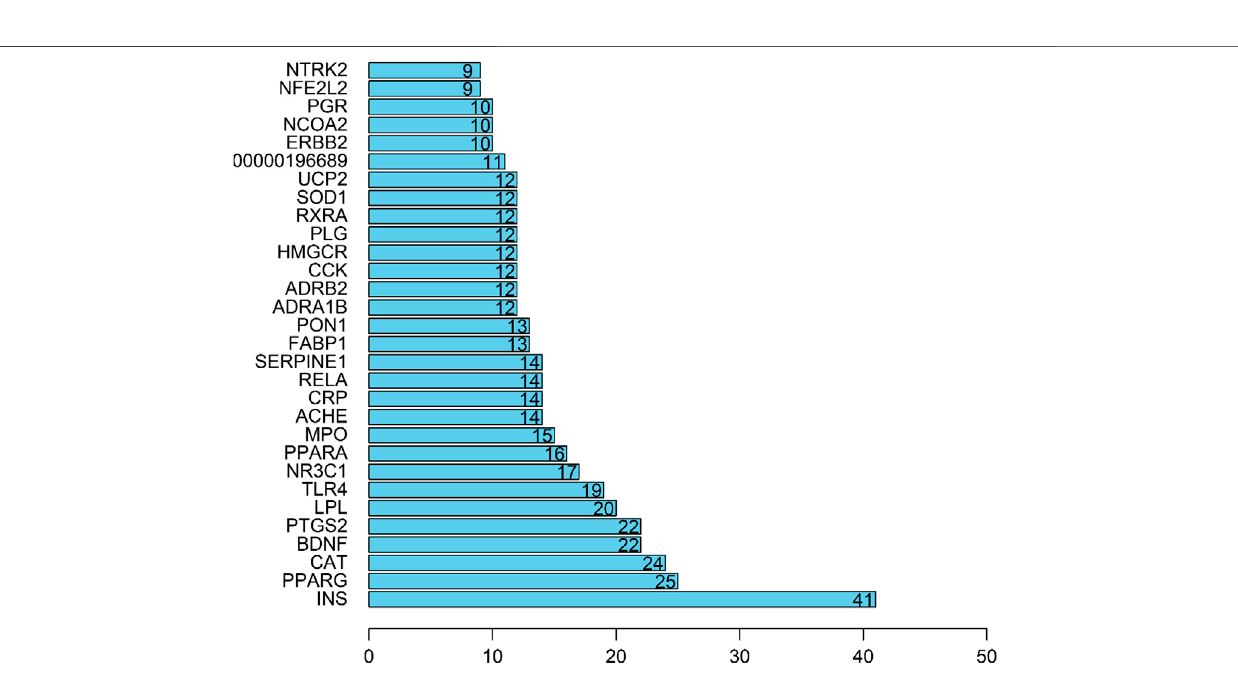
Frontiers in Pharmacology |